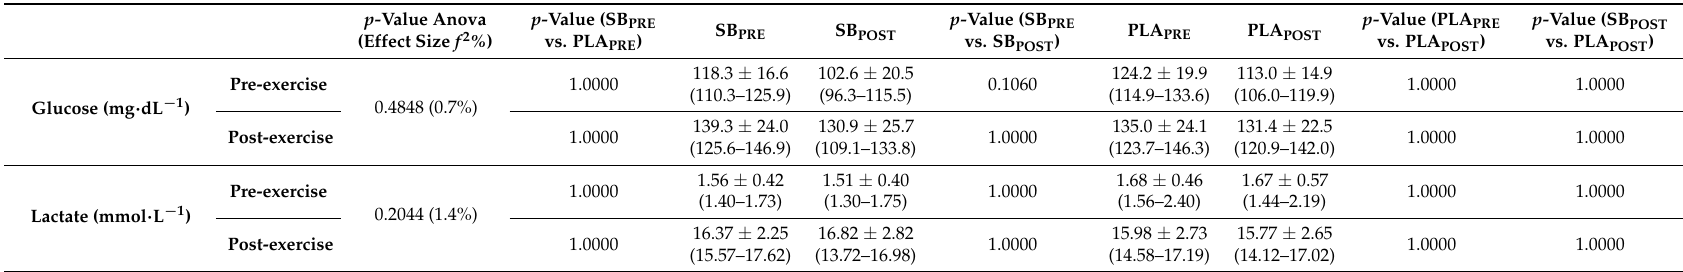
Table 4. Glucose and lactate